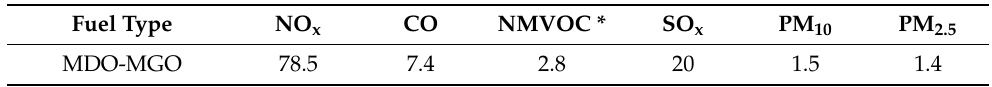
Table 6. Tier 1 engine emission factors (kg/t) for hoteling [38,43].